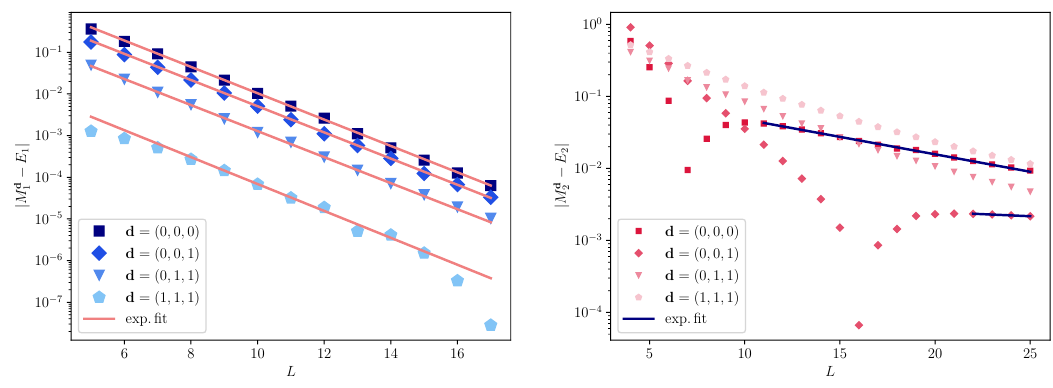
Figure 6 . The difference between the finite- and infinite-volume binding energies for the deep (left panel) and shallow (right panel) bound states. Note that for a better visibility, we have divided the energy shift of the deep bound state, corresponding to d = (1 , 1 , 1) , by a factor 25 . Otherwise, the data for d = (0 , 1 , 1) and d = (1 , 1 , 1) would nearly overlap.